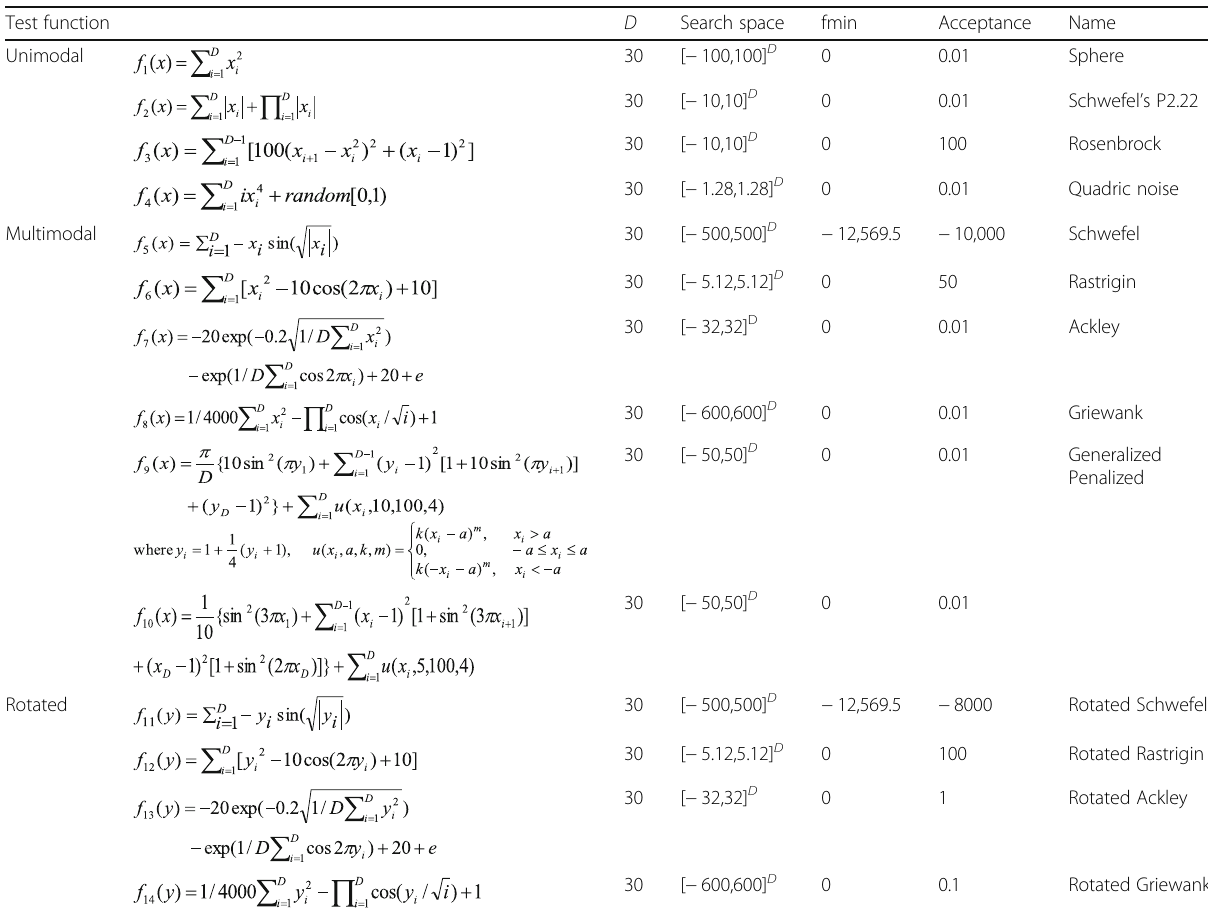
Table 2 Functions tested Test function D Search space